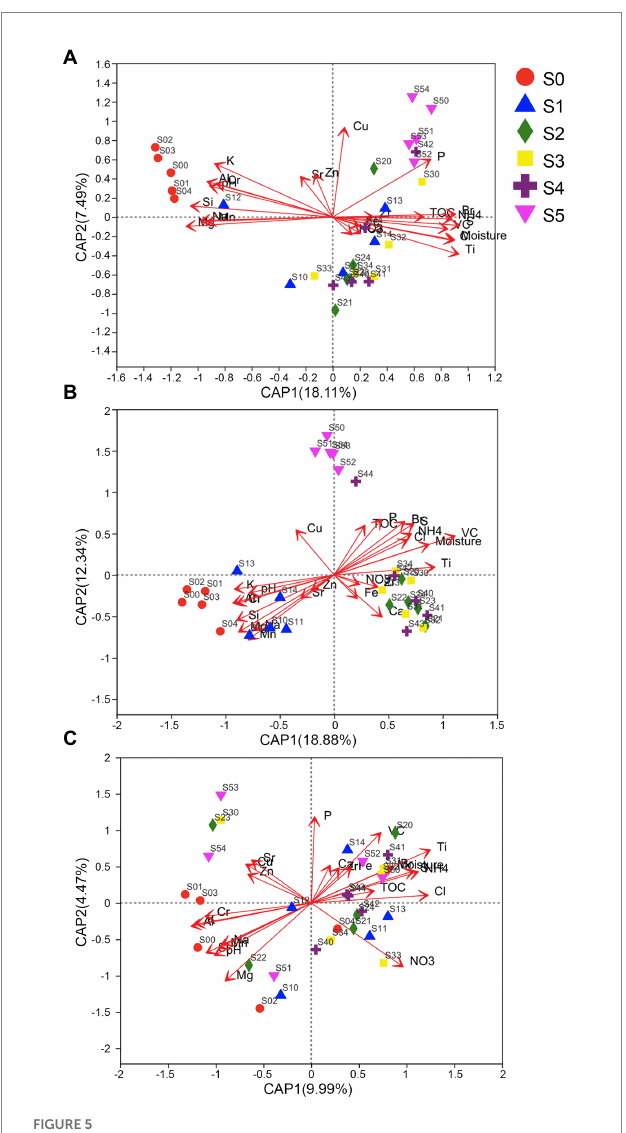
FIGURE 5 Distance-based redundancy analysis (db-RDA) analysis of (A) bacterial, (B) archaeal, and (C) fungal communities in various strata and environmental